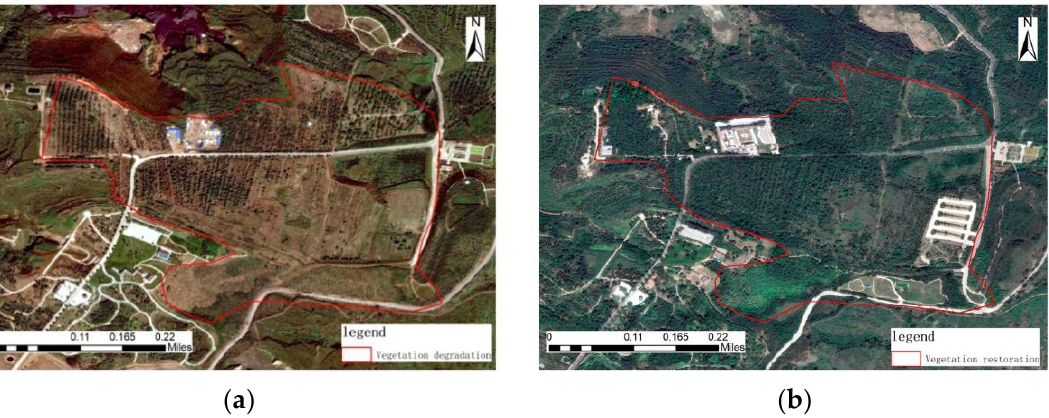
Figure 9. Remote sensing images before and after ecological restoration in the vegetation degradation restoration area. ( a ) before treatment; ( b ) after treatment.